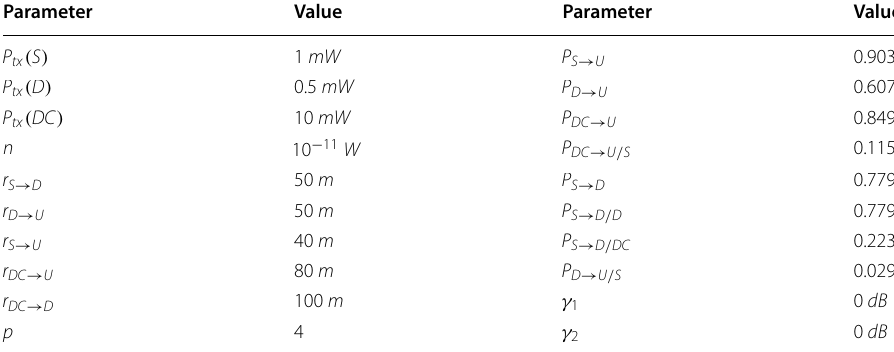
Table 2 Wireless links parameters Parameter